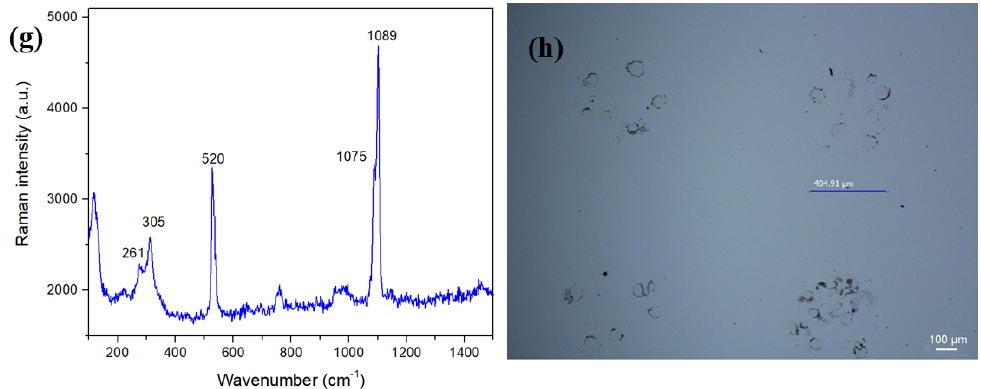
Figure 5. SEM images of crystals formed in a droplet with a polyacrylic acid (PAA) content of ( a ) 0.1 mg/ml, ( b ) 0.2 mg/ml and ( c ) 0.4 mg/ml; SEM images of crystals formed on bulk phase synthesis with PAA( d ) 0.1 mg/ml, ( e ) 0.2 mg/ml and ( f ) 0.4 mg/ml; ( g ) Representative Raman spectrum of sphere-shaped crystals, which has the characteristic peaks of vaterite at 261, 305, 1075, and 1089 cm − 1 ; ( h ) Optical micrograph of CaCO 3 crystals formed in 400 µm diameter droplets.